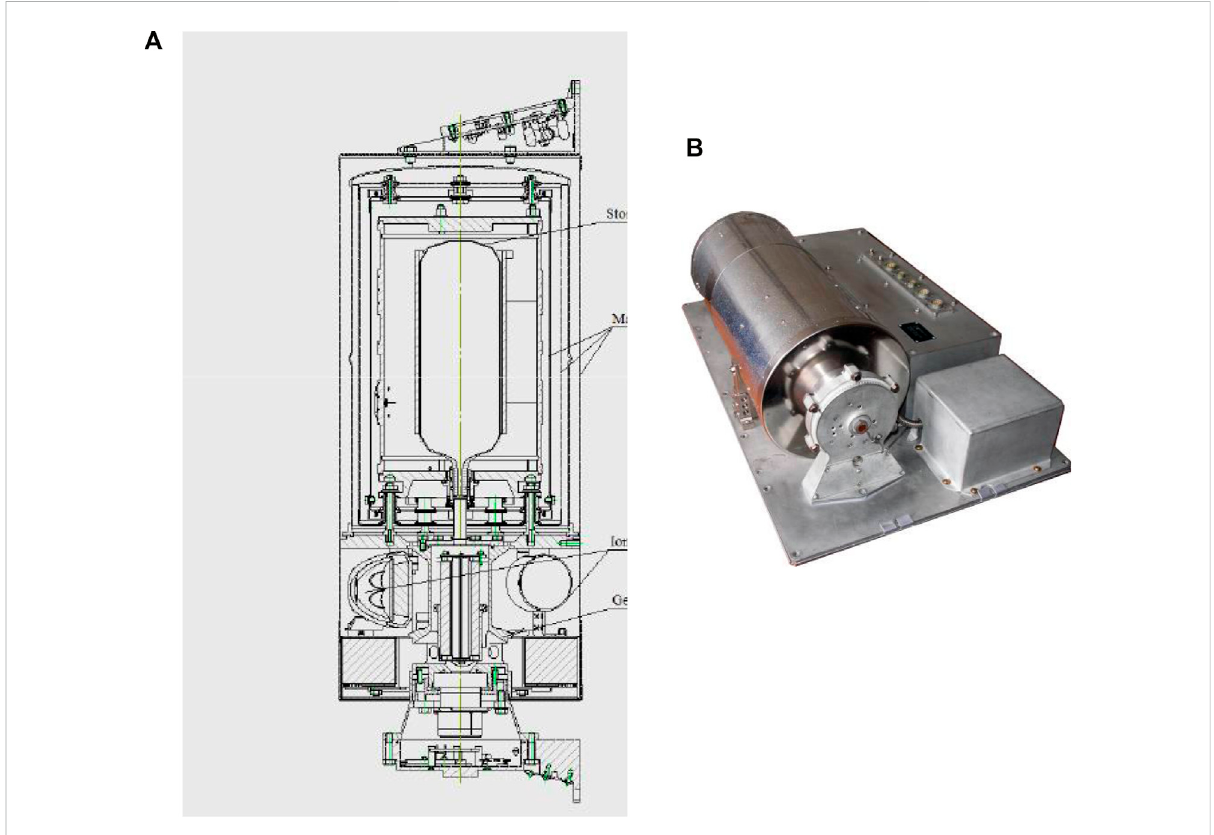
FIGURE 12 Passive H-masers. (A) Flight model unit designed by Vremya – CH. (B) Flight model passive H-maser fromVremya –